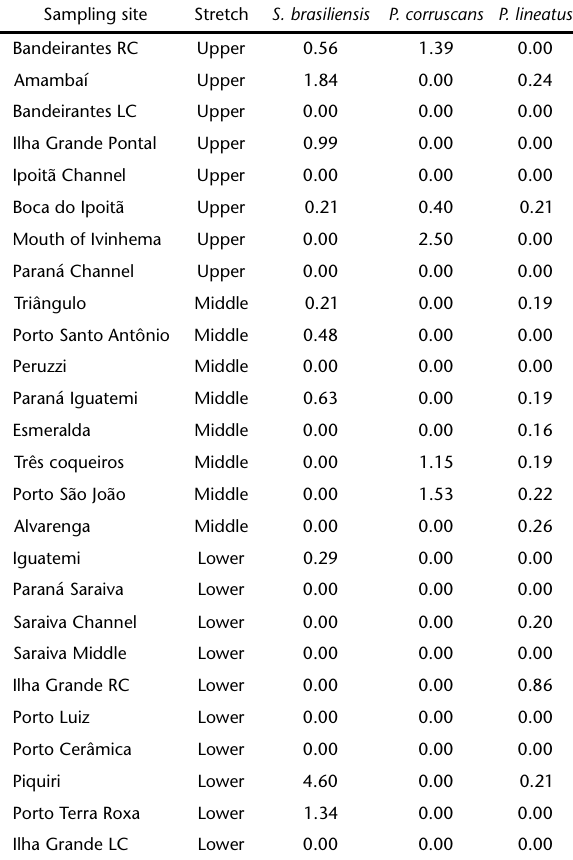
Table 1. Relationship between the density of larvae Salminus brasiliensis , Pseudoplathystoma corruscans and Prochilodus lineattus and sampling